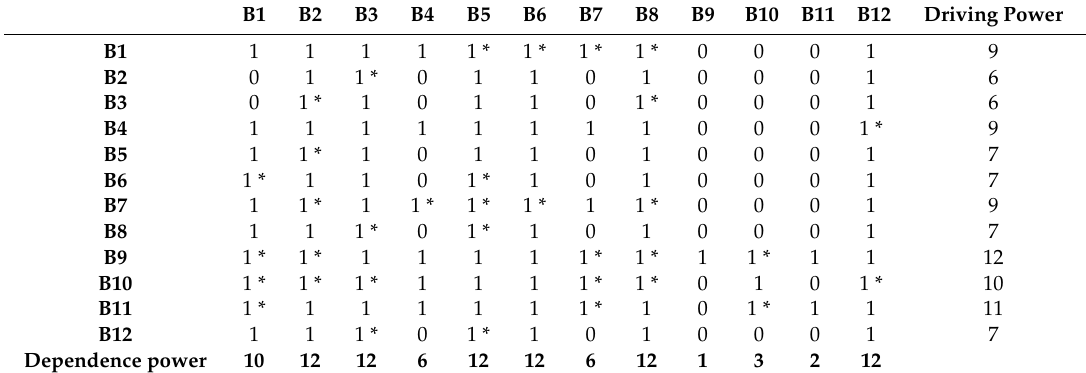
Table 10. Final Reachability Matrix.